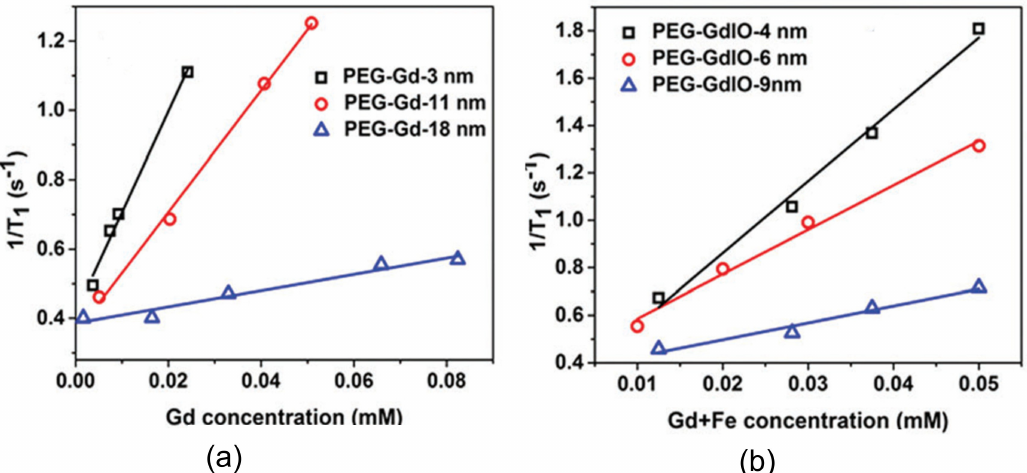
Figure 14. T 1 relaxation rate versus the accumulation of nanocomposites originating from (left) Gd 2 O 3 nanodiscs with di ff erent sizes and (right) spherical GdIO nanoparticles with a diameter of 6 nm and 9 nm, as well as squared nanostructures with a side of 4 nm. Reproduced with permission from G. Singh, B. H. McDonagh, S. Hak, D. Peddis, S. Bandopadhyay, I. Sandvig, A. Sandvig and W. R. Glomm; “Synthesis of gadolinium oxide nanodisks and gadolinium doped iron oxide nanoparticles for MR contrast agents”; Journal of Materials Chemistry B; 5(3); 418-422 (2017), from The Royal Society of